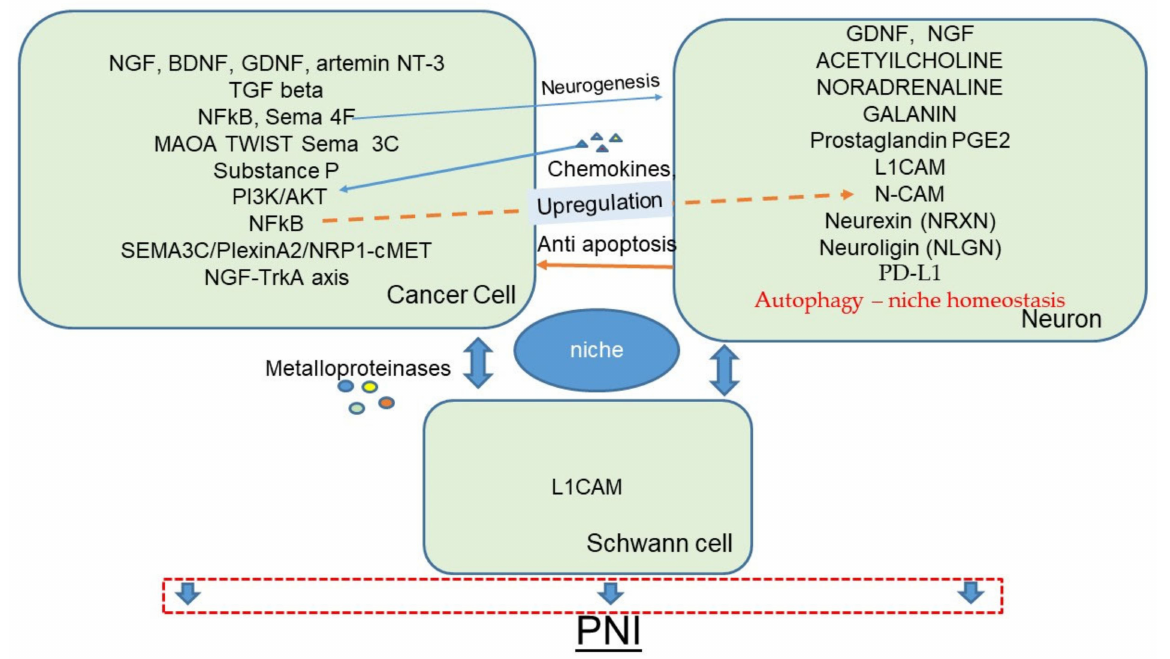
Figure 2. Examples of molecular mechanisms involved in PNI/perineural niche that are presented in this review. Major cell types in the perineural niche, as well as various soluble signaling molecules and their receptors, form a complex signal network that allows nerves and tumors to interact. For recent perineural-niche- and PNI-focused reviews, see